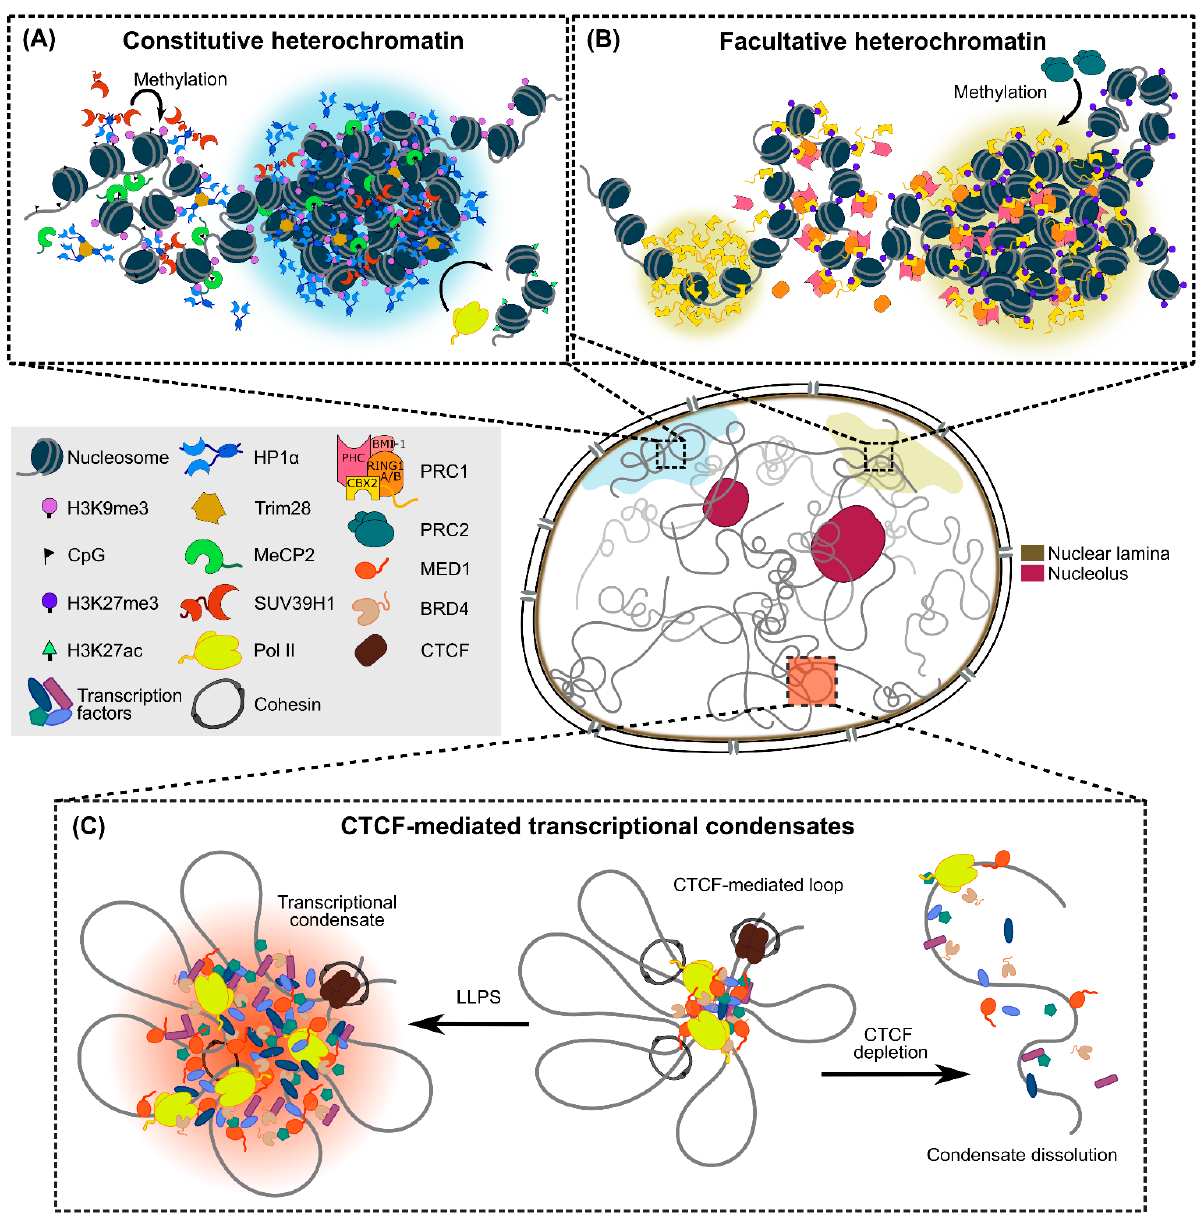
Figure 3. Intranuclear organization of chromatin via phase separation into large- and intermediate- scale condensates. ( A ) HP1 α dimer binding to H3K9me3 on heterochromatin initiates condensate formation; further interactions with SUV39H1 and TRIM28 lead to higher-order oligomers that enhance LLPS to establish highly compact constitutive heterochromatin. Moreover, MeCP2 can also phase separate with HP1 α , while the exclusion of H3K27ac and Pol II from the condensates further segregates the heterochromatin phase from the surrounding transcriptionally active regions. ( B ) Upon deposition of H3K27me3 marks on chromatin by PRC2, CBX2 binds to H3K27me3 and undergoes LLPS to establish facultative heterochromatin. The assembly of other PRC1 subunits further enhances the initial condensed phase into larger condensates. ( C ) CTCF-mediated chromatin looping provides an architectural framework for the local enrichment of various transcriptional machineries (e.g., Pol II, MED1 and BRD4) and drives the formation of transcriptional condensates via LLPS. Depletion of CTCF dissolves these condensates.